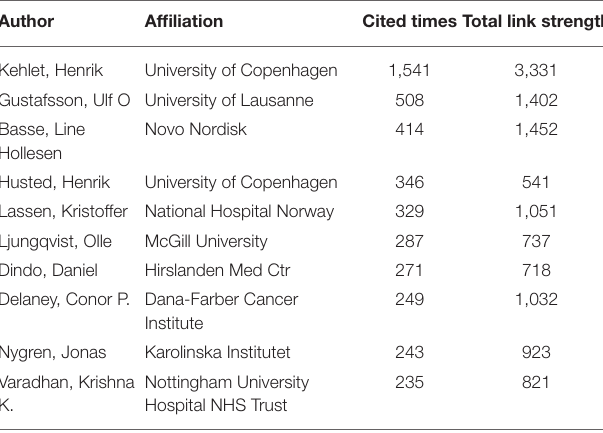
TABLE 3 | Top 10 most-cited authors in the reference lists.